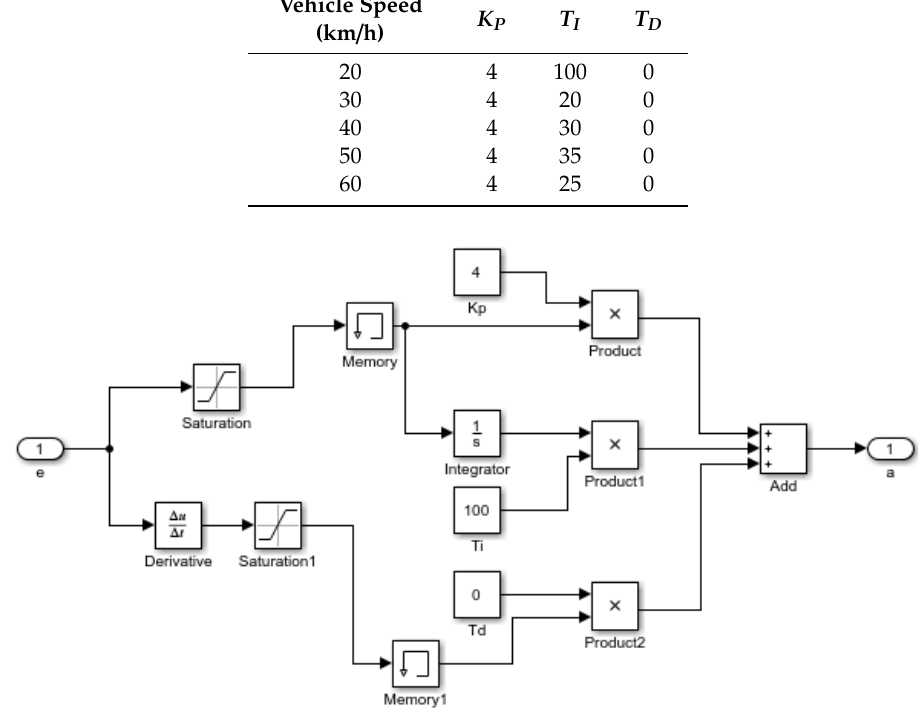
Figure 20. The PID lower controller model.